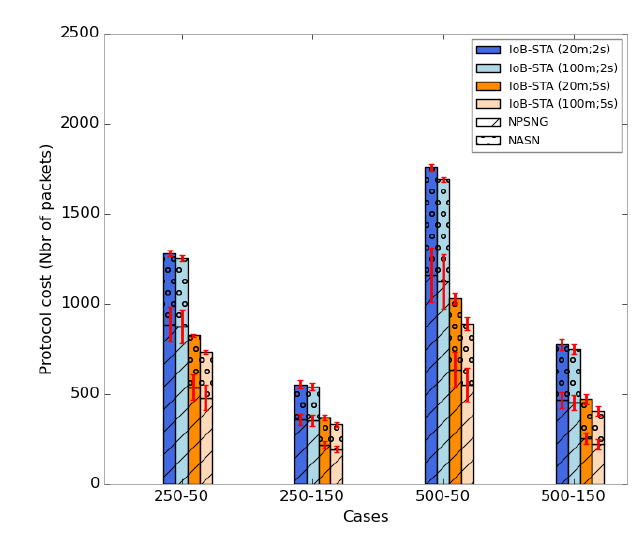
Figure 37. Average protocol cost for IoB-STA.